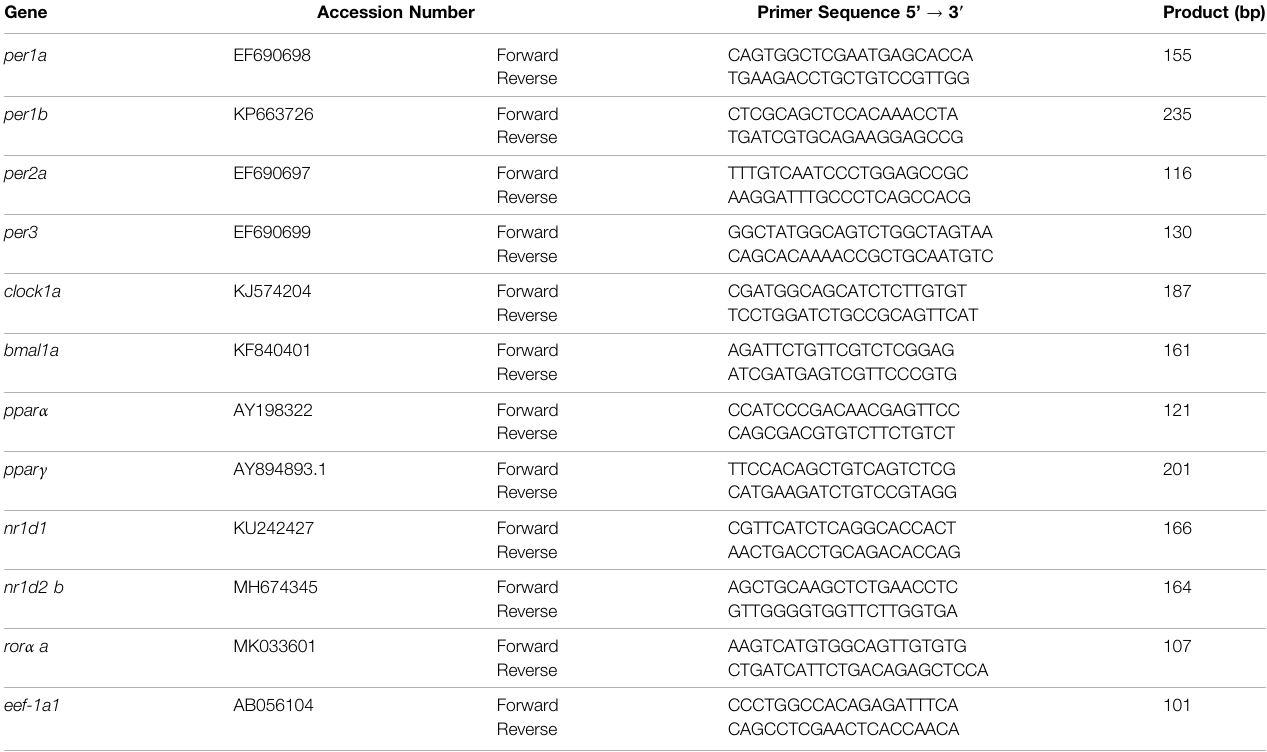
TABLE 1 | Accession numbers of the genes and primers sequences employed in quantitative RT-qPCR studies.